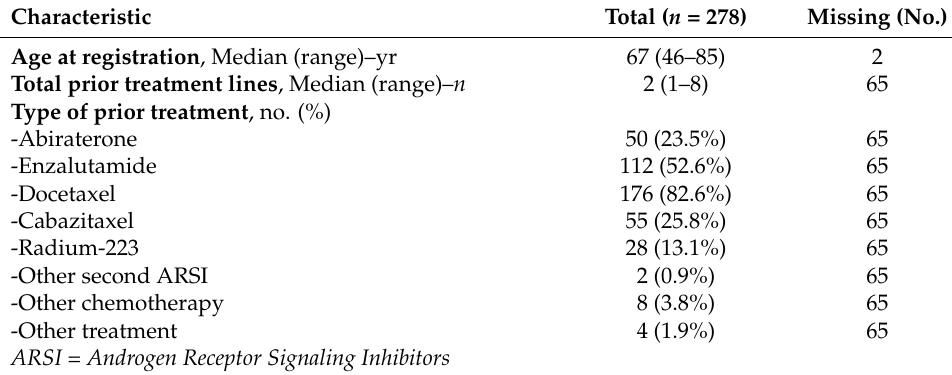
Table 1. Baseline characteristics of included mCRPC patients